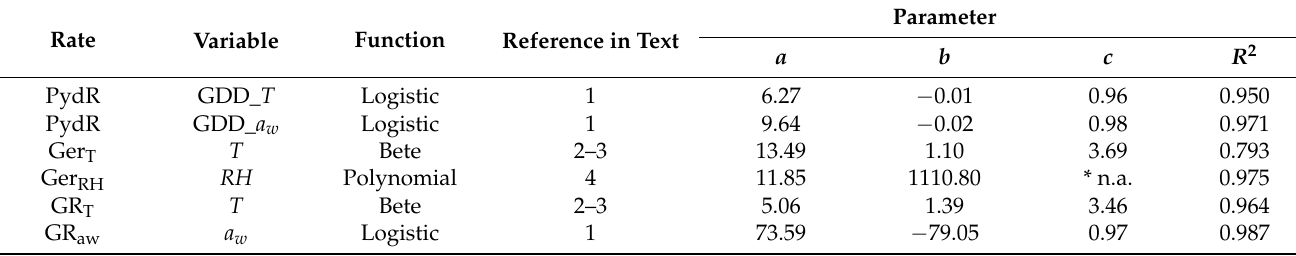
Table 1. Summary of functions used for fitting data collected in different steps of infection cycle and computed parameters (Arciuolo et al. [18],